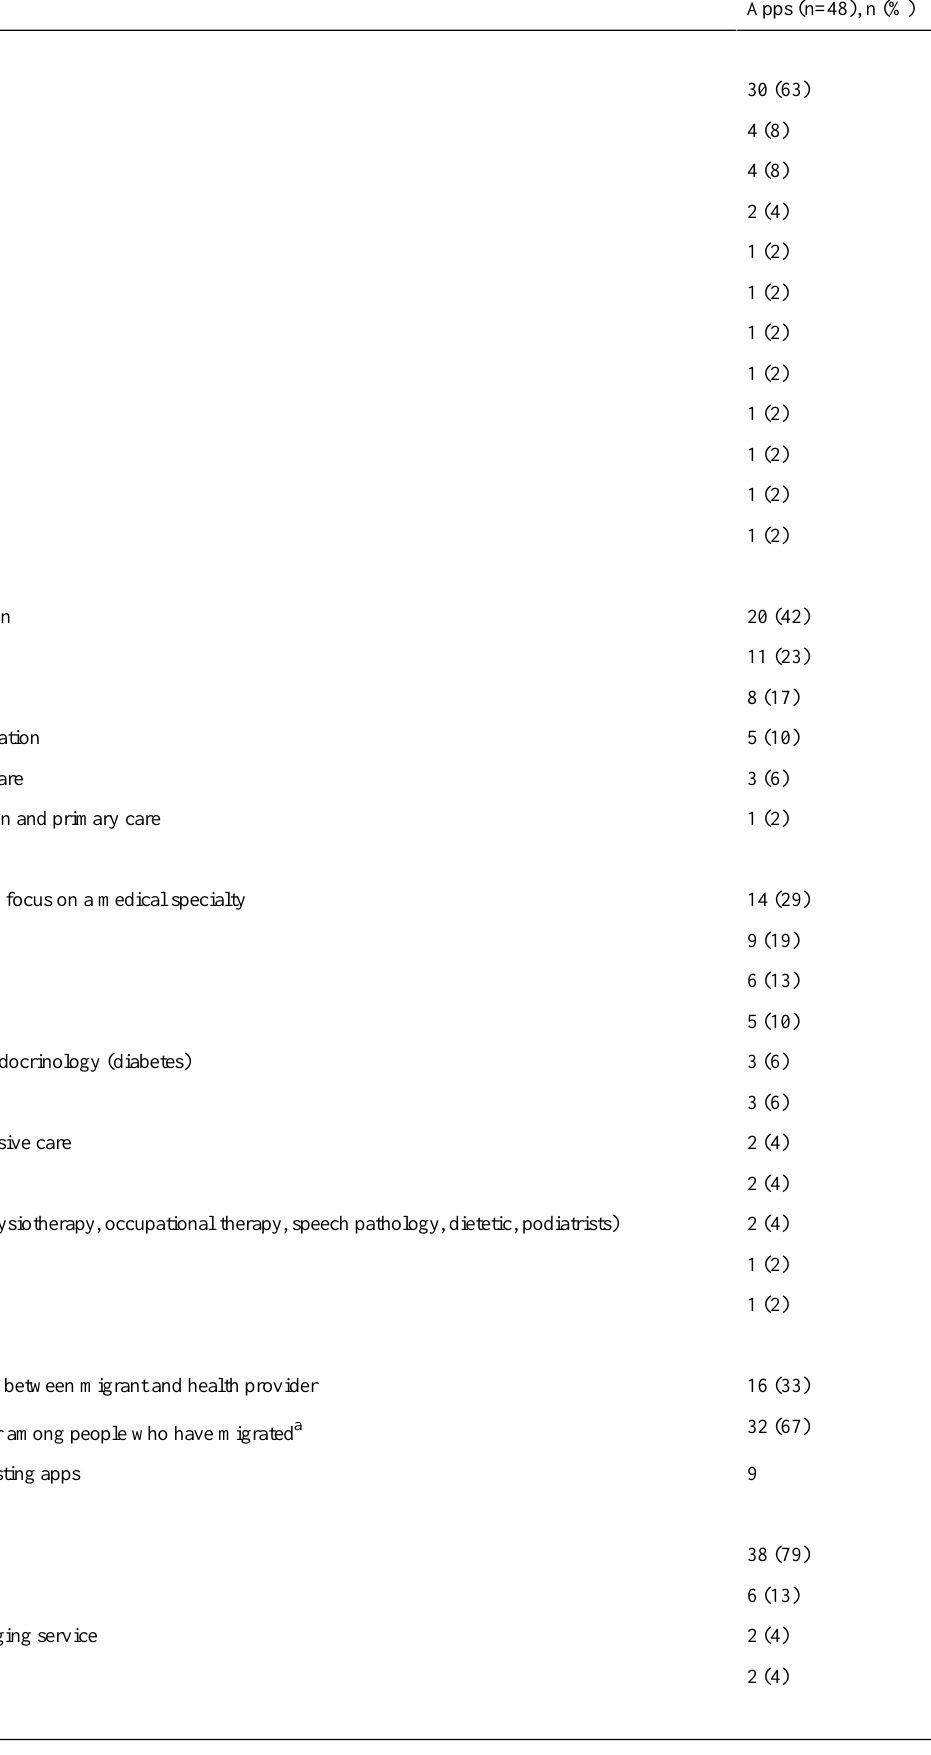
Table 2. Characteristics of apps included in the